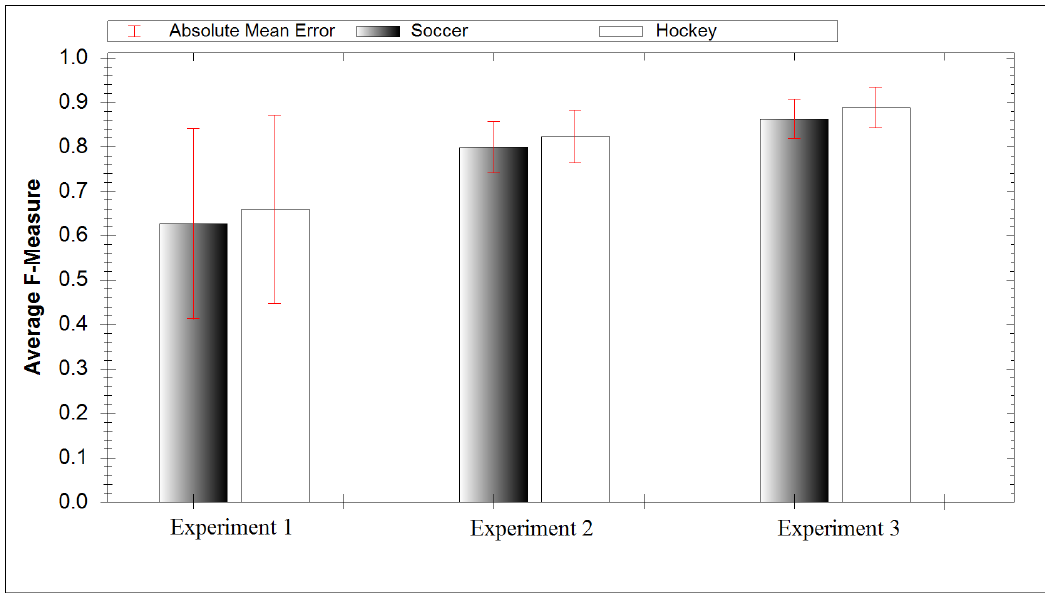
Figure 8. Average model accuracy for each